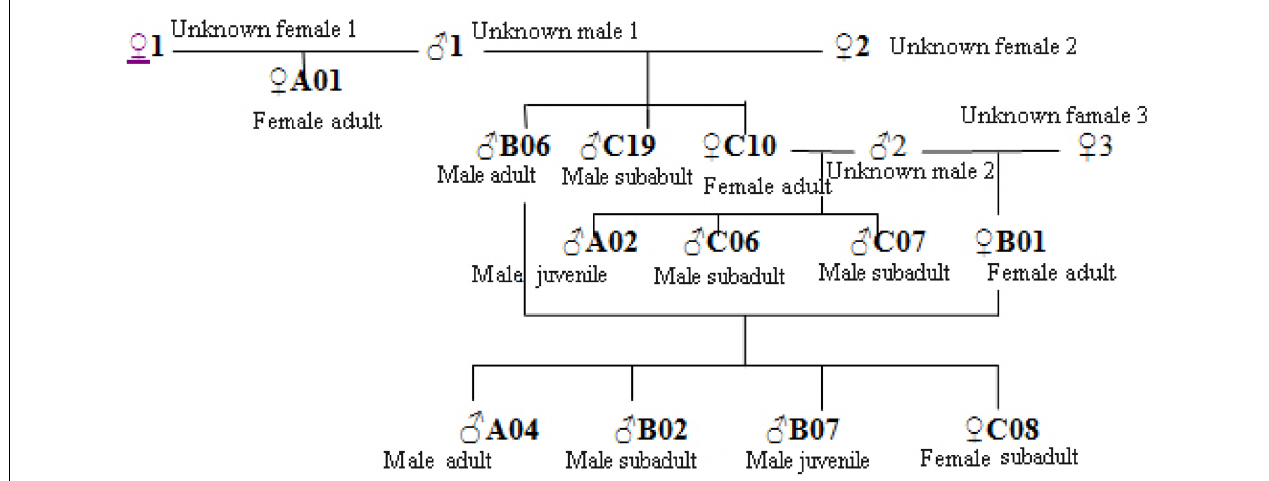
FIGURE 7 | Kinship diagram of individuals in Groups A, B, and C. Based on these results, both males and females transfer between established groups, and given the existence of new groups (D and E), individuals periodically form new groups.